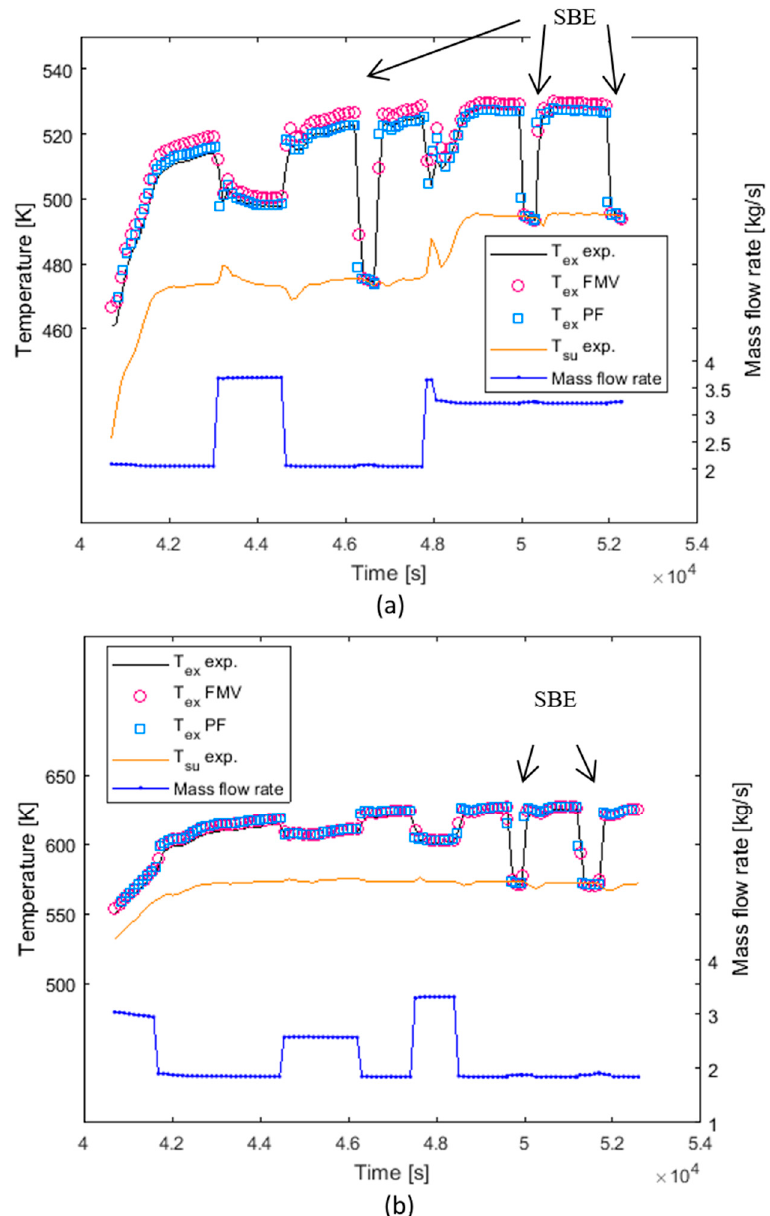
Figure 4. Experimental results performing different days versus plug flow and finite volume methods for several inlet temperature, mass flow rate and solar beam conditions. ( a ) Test conditions #3; ( b ) Test conditions #4.